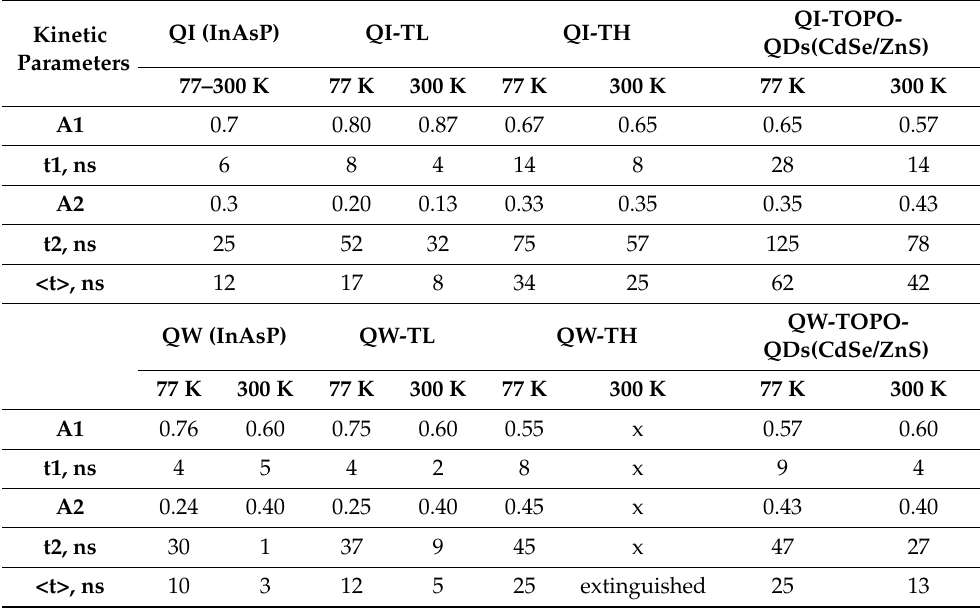
Table 1. The parameters of nanoinsertion (QI) and quantum well (QW) kinetics at 635 nm wave- length excitation. Kinetic